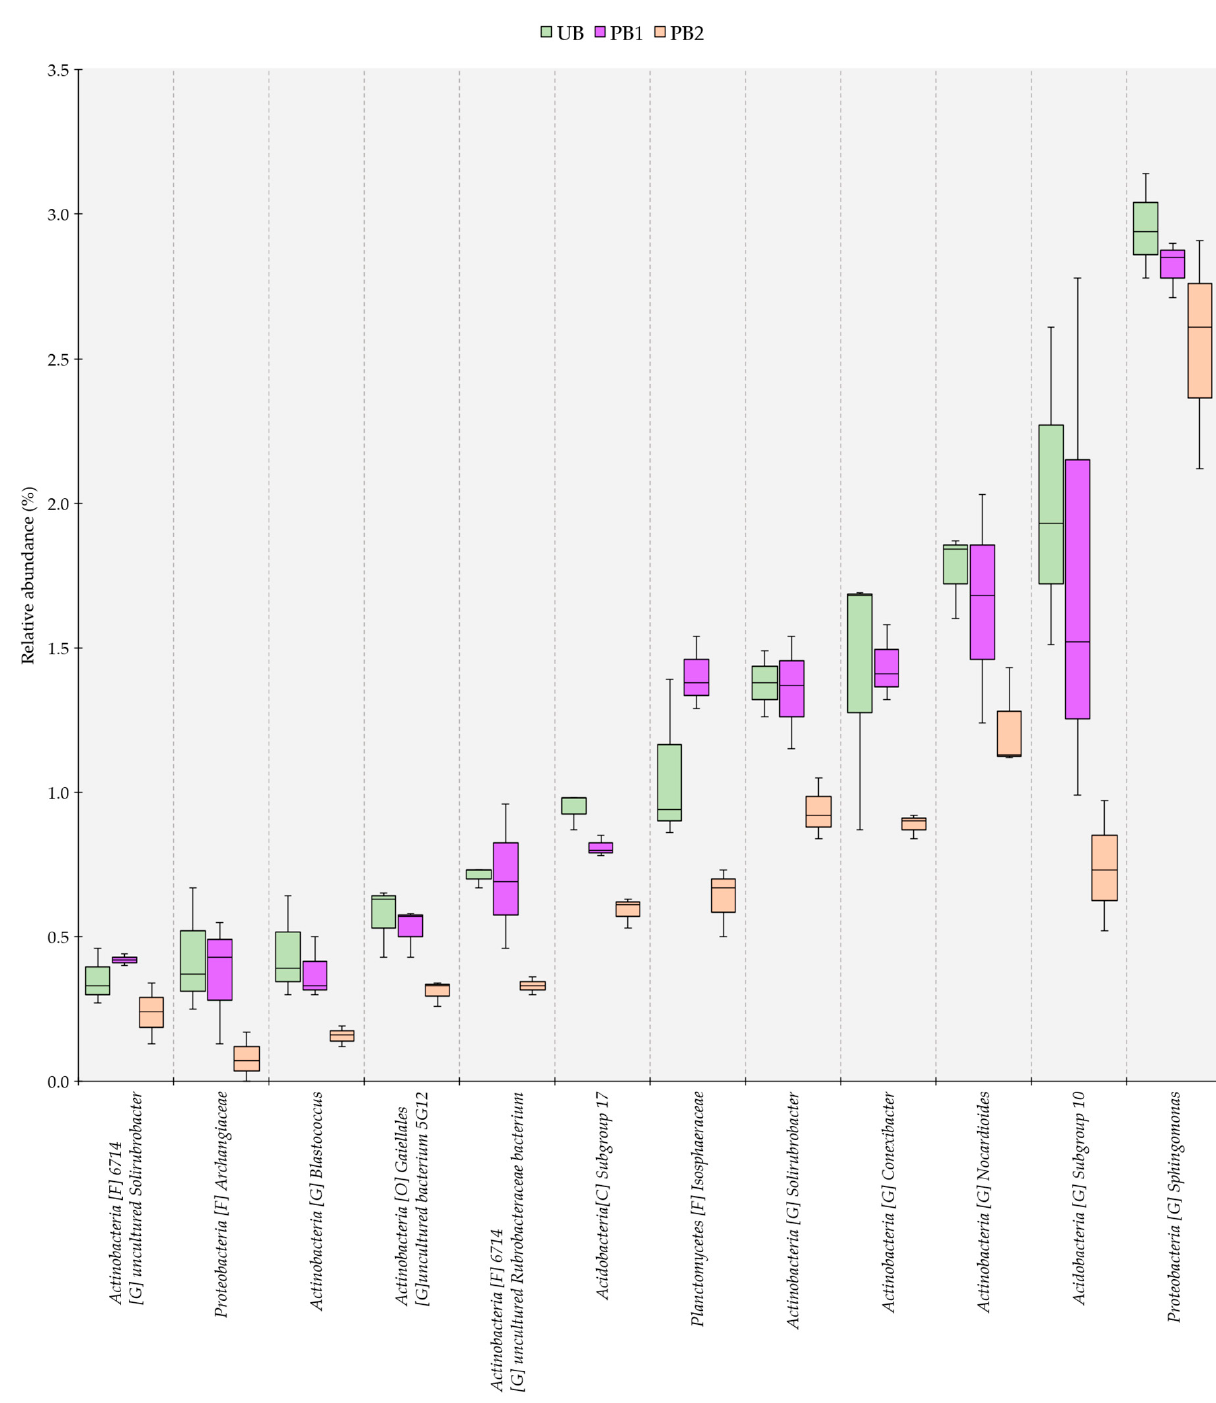
Figure 6. Bacterial groups showing a relative abundance (%) similar to UB seven months after application and bacterial group decreasing in relative abundance (%) after a recent prescribed burning treatment (PB2) respect to UB. UB: control; PB1: soils treated with prescribed burning seven months before sample collection; PB2: soils treated with prescribed burning immediately prior to sample collection. Boxes include 50% of the data between the first and third quartiles (interquartile range) and the central line, the median. The whiskers include those values that deviate from the first and third quartiles up to a maximum distance of 1.5 times the interquartile range. Capital letters in square brackets indicate the lowest taxonomic level of classification: [O]: order, [C]: class, [F]: family, [G] genus.